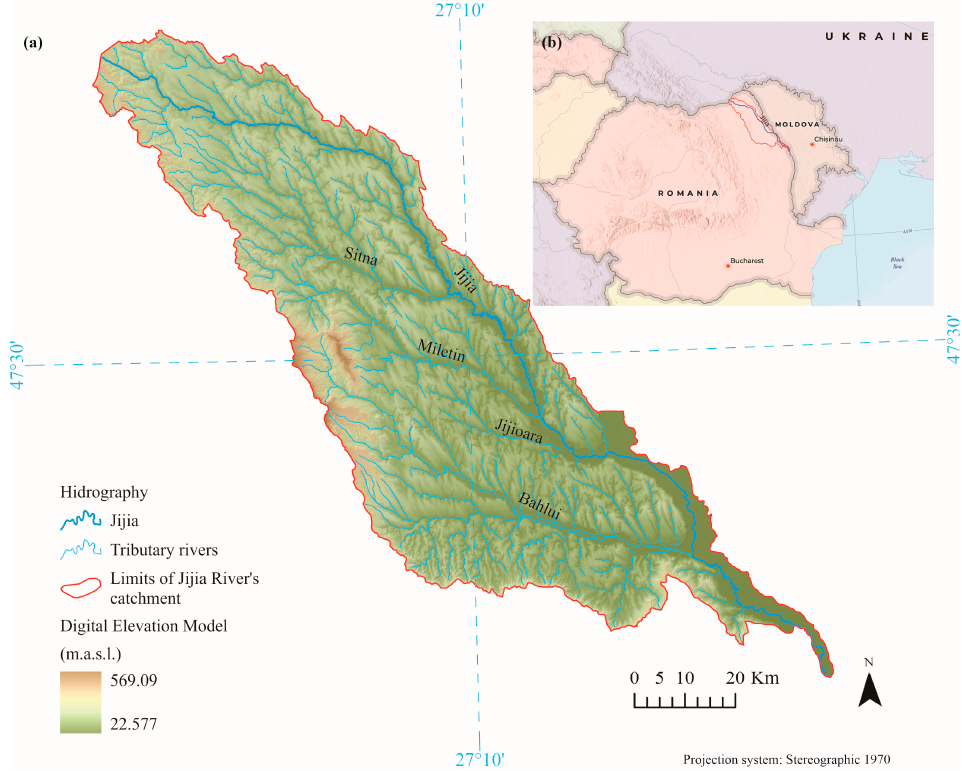
Figure 1. ( a ) Jijia River and its tributaries on the DEM of the Jijia River catchment; ( b ) the location of the Jijia River catchment within the territory of Romania and neighboring countries. Source of DEM: LiDAR-derived DEM from Romanian Water Administration, Prut-Bârlad branch, 1 × 1 m resolution.